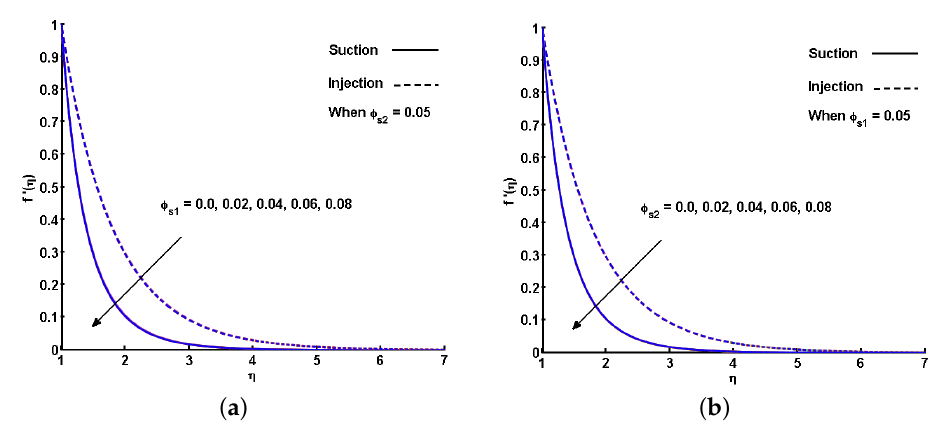
Figure 7. Effect of volume fraction of nanoparticles ( φ s 1 and φ s 2 ) on velocity profile ( f (cid:48) ( η )) ( a ) φ s 1 is varied and φ s 2 is fixed; ( b ) φ s 1 is fixed and φ s 2 is varied.